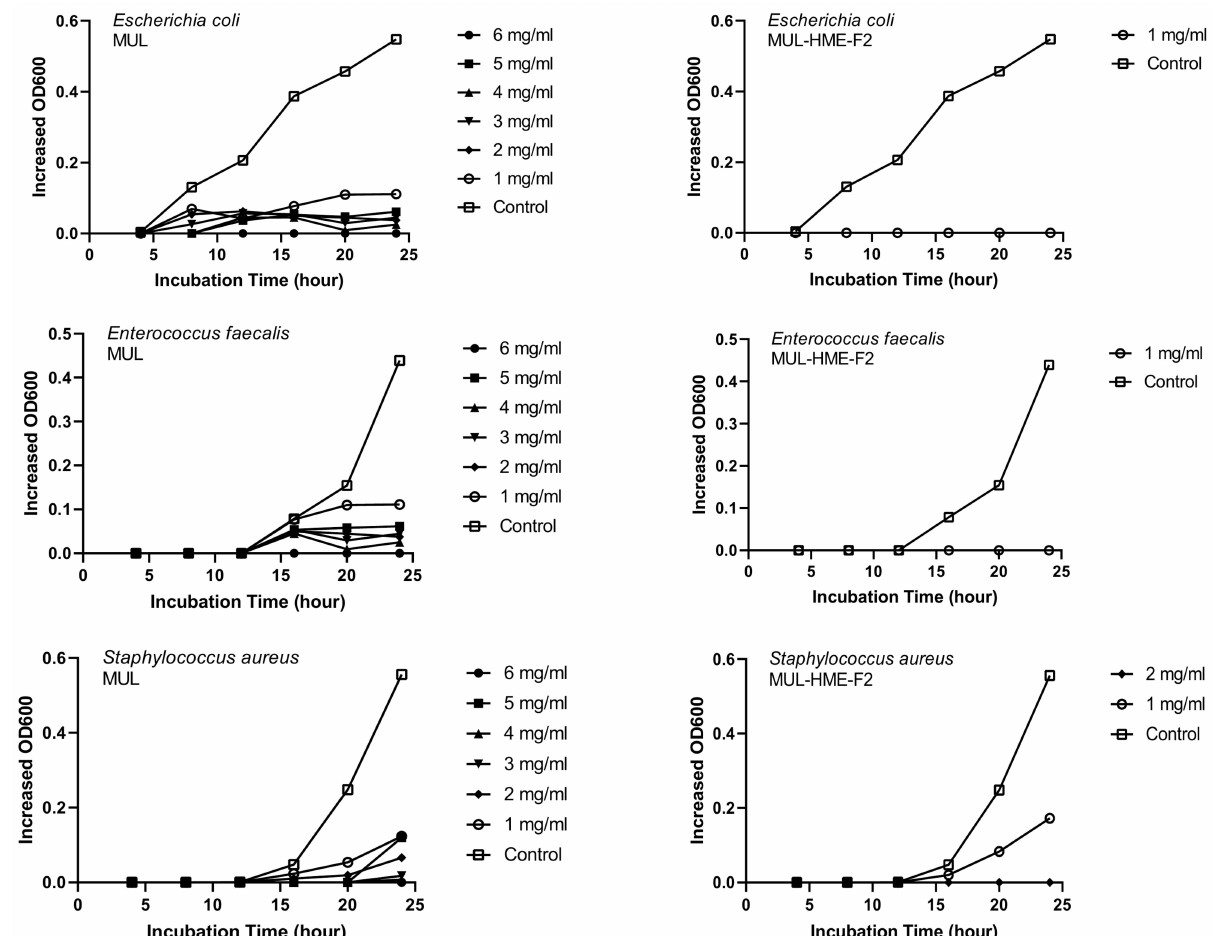
Figure 5. Growth inhibition effects of mulberry raw materials and HME-DDS formulations (HME- MUL-F2) on pathogen bacteria.In the case of HME-MUL-F2, bacterial growth was completely inhib- ited at a relatively lower treatment concentration. Since HME-MUL-F2 was composed of a highly water-soluble ascorbyl palmitate as an excipient, it could inhibit the growth of bacteria or other microorganisms [62]. As for the mannitol, it could enhance the thermal stability of the mixed mate- rial. The poloxamer 188 and sodium alginate played a role in protecting the active ingredient. As reported previously, ACNs can inhibit the growth of E. coli and S. aureus [63]. HME-MUL-F2 showed antibacterial activities even at low concentrations. It is confirmed that the antibacterial effect on higher pathogens was exhibited under the influence of the excipients